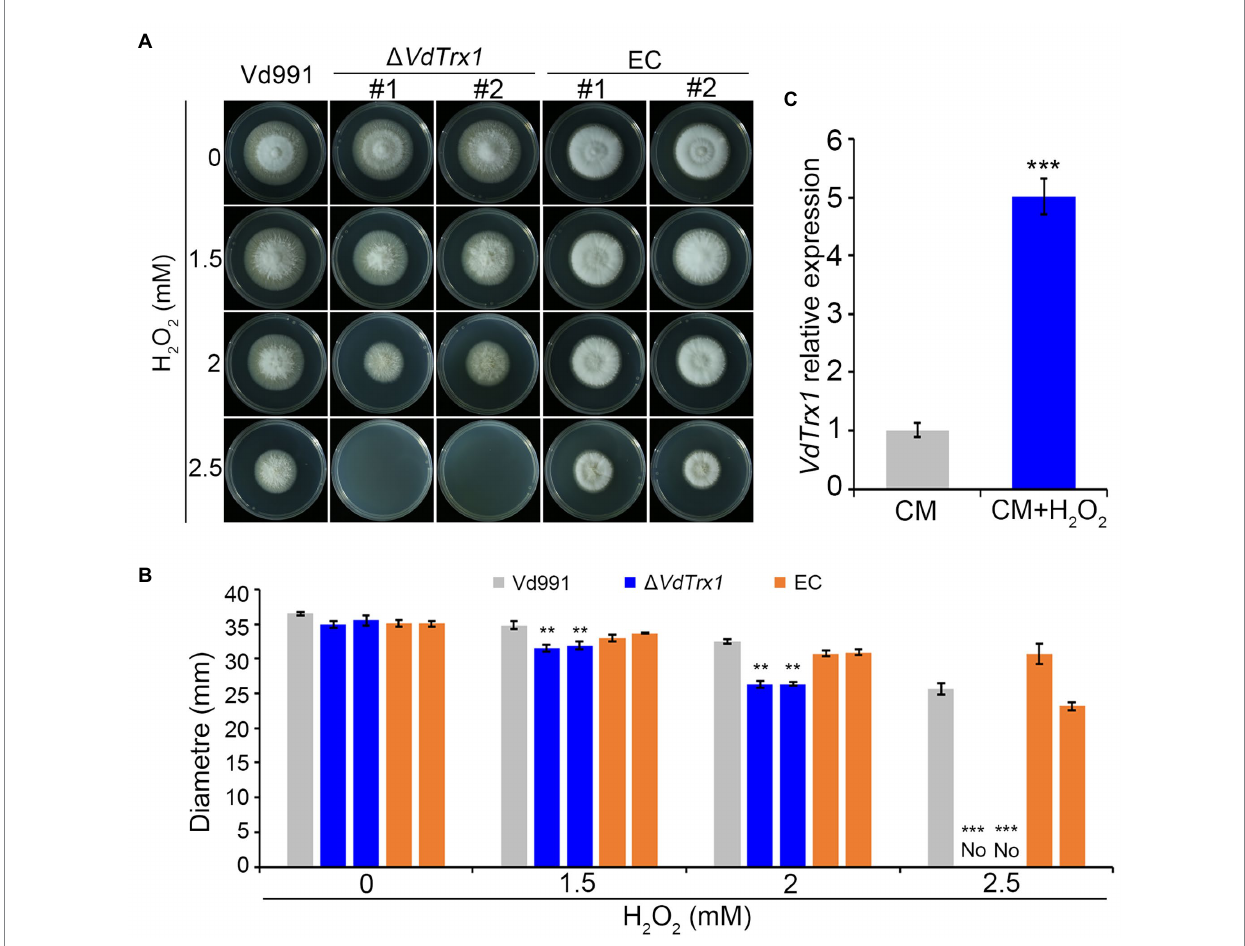
FIGURE 2 VdTrx1 of V. dahliae mediates the response to oxidative stress. (A) Radial growth of VdTrx1 deletion strains, complemented strains (EC#1 and #2) and wild-type strain (Vd991) on CM (complete medium) supplemented with H 2 O 2 at specified concentrations for 9 days. (B) Colony diameters of various V. dahliae strains on CM plates containing different concentration of H 2 O 2 following 9 days incubation. Means and standard deviations of the mean from three biological replicates are shown. Asterisks (**) and (***) denote significant differences p < 0.01 and p < 0.001, respectively, according to Student’s t -test. (C) Reverse transcription-quantitative PCR (RT-qPCR) of VdTrx1 transcripts in V. dahliae hyphae treated with 1.0 mM H 2 O 2 or incubated in CM only for 3 h. Total cDNA abundance in the samples was normalized to using VdEF-1 α gene as a control. In RT-qPCR, expression of VdTrx1 in the strain without H 2 O 2 treatment was set as 1. Bars indicate standard deviations from three biological replicates, *** denotes significant differences at p < 0.001 (Student’s t